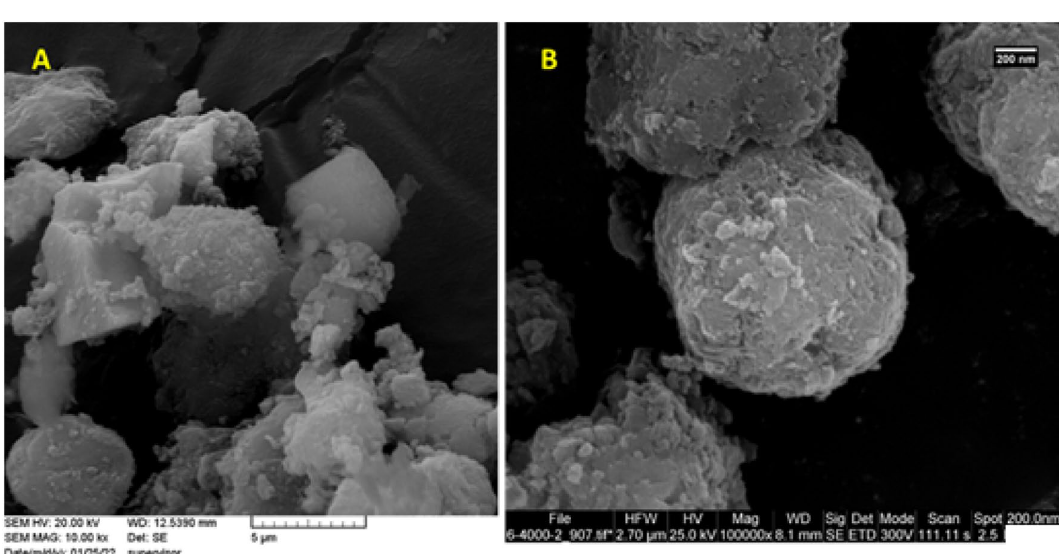
Figure 3. SEM images of ( A ): boehmite and ( B ):